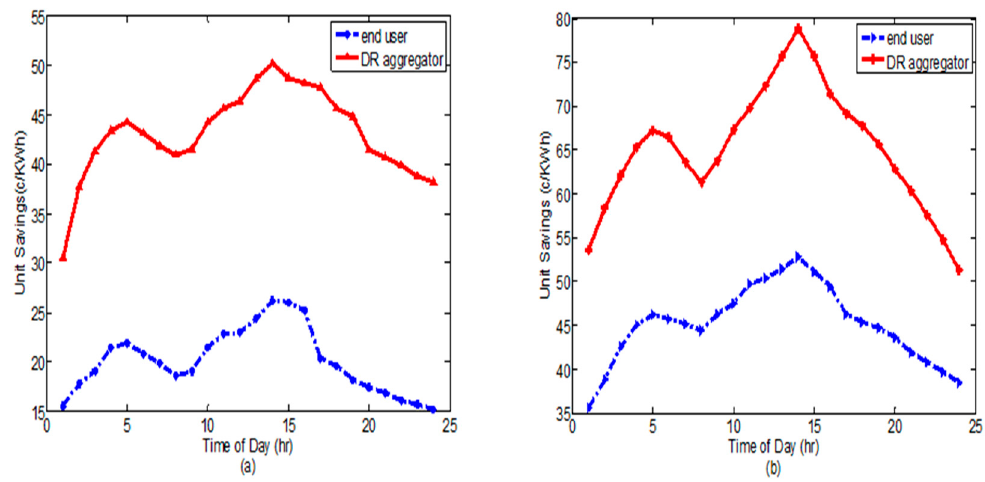
Figure 4. Unit energy savings for end users and the DR aggregator ( a ) when the DSO utilizes RES and ( b ) when end users utilize RES.